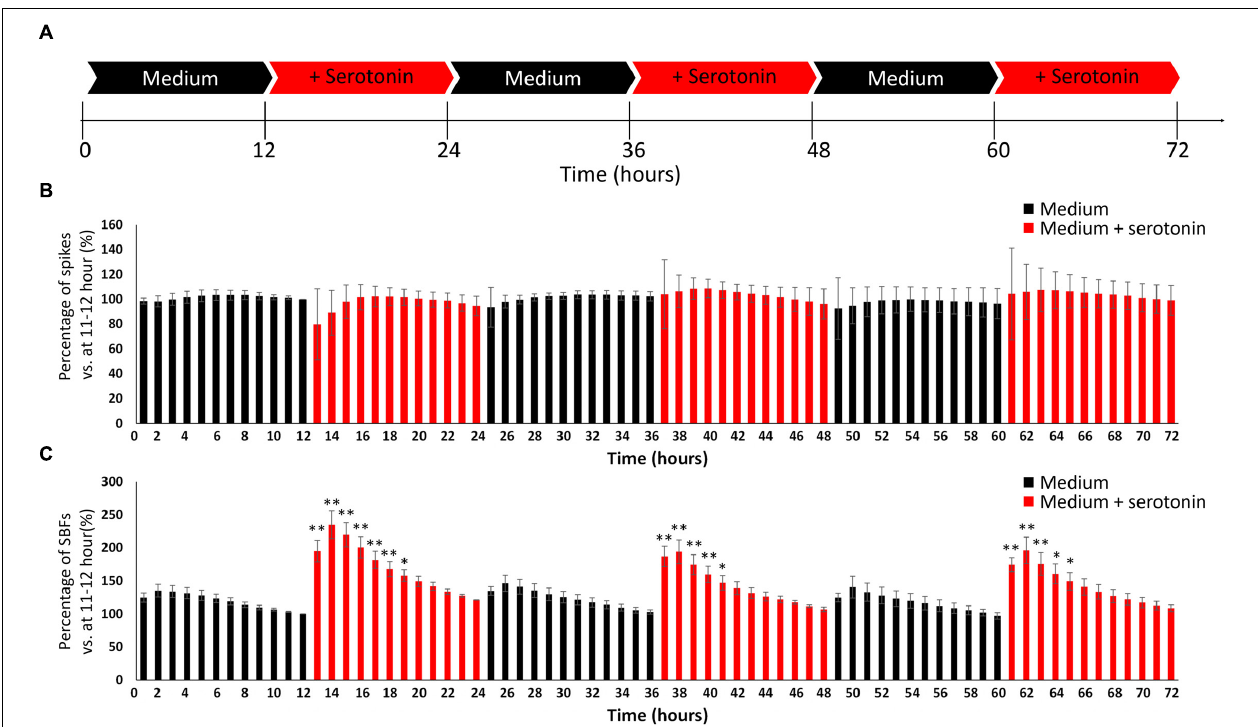
FIGURE 4 | Evoking an awake-like rhythm through the periodic administration of serotonin. (A) Illustration of experimental scheme. The medium in cultured dopaminergic neurons was replaced with medium only (black arrows) or medium and serotonin (100 nM, red arrows) every 12 h. Two conditions were alternately repeated three times in a 12-h cycle, and spontaneous firings were measured for 72 h. Spontaneous firings were analyzed for every 1 h. (B) Changes in the number of spikes versus 11–12 h (%). (C) Changes in the number of SBFs versus 11–12 h (%). ( n = 3, N is the number of wells and is the result of different culture samples. One-way ANOVA and post hoc Dunnett’s test, ∗ p < 0.05, ∗∗ p < 0.01 vs. 11–12 h). Black bars show the data for medium only, and red bars show the data for medium and serotonin (100 nM)